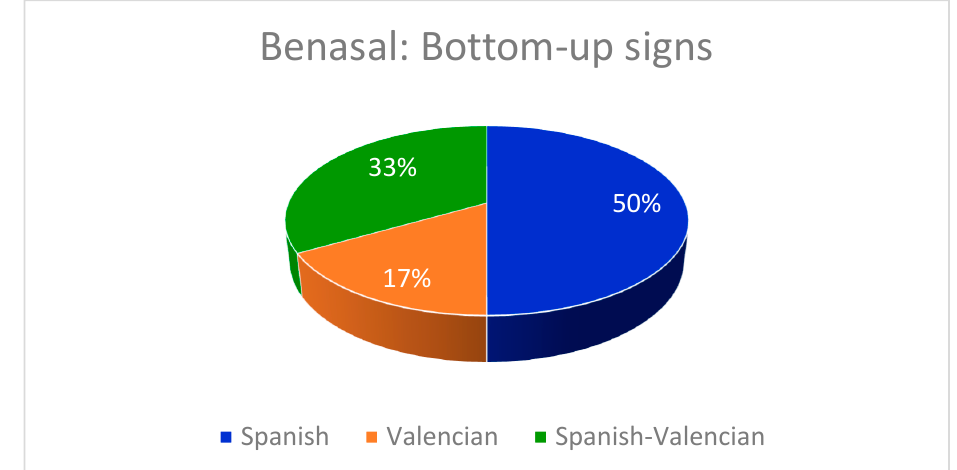
Figure 24. Benasal: Bottom-up signs.